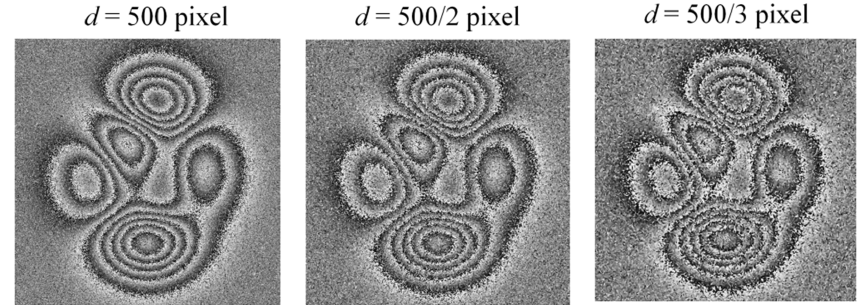
Figure 3. Estimated wrapped phases with the different aperture sizes.